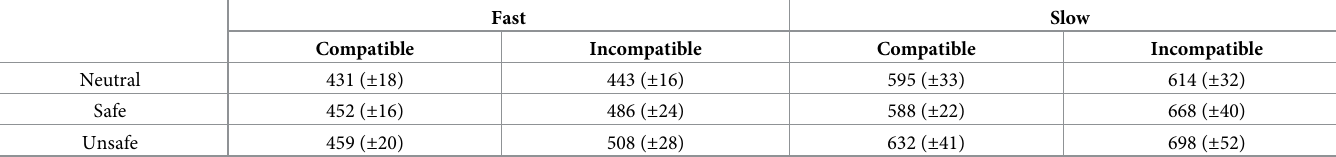
Table 1. Mean participant reaction time (ms) ( ± SE) within compatible and incompatible stimulus-response trials as a function of prime group and reaction time bin (fast,